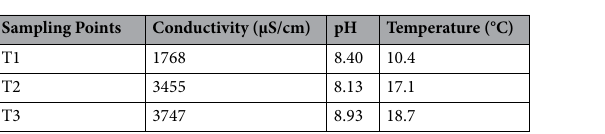
Table 1. Water parameters obtained in situ from sampling points in Salar de